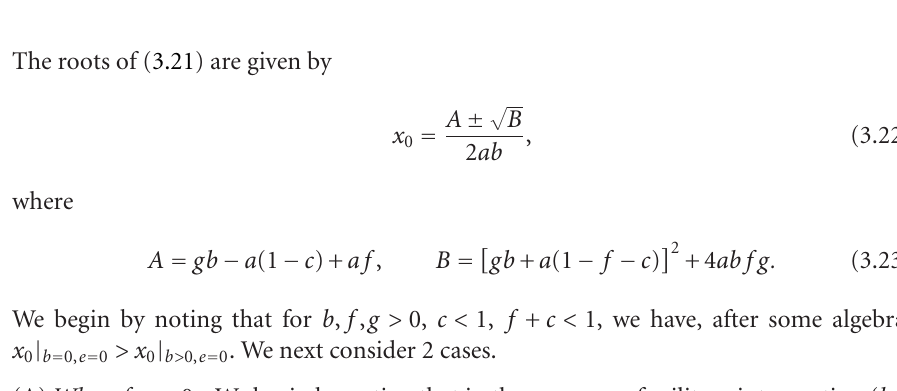
Figure 3.10. Phase plot showing the ine ff ectiveness of nonviolent intervention in curbing the terrorist population. Parameter values are same as those for Figure 3.1 except that e = 0 . 0001. The vector field has a positive x -component of velocity and hence the terrorist population continually